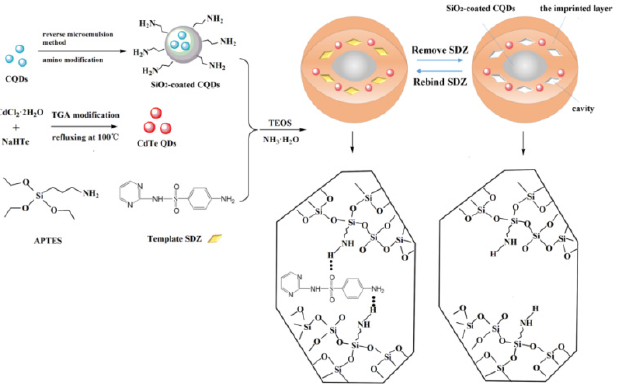
Figure 4. A schematic diagram for the preparation of ratiometric fluorescence nano-sensors [109].